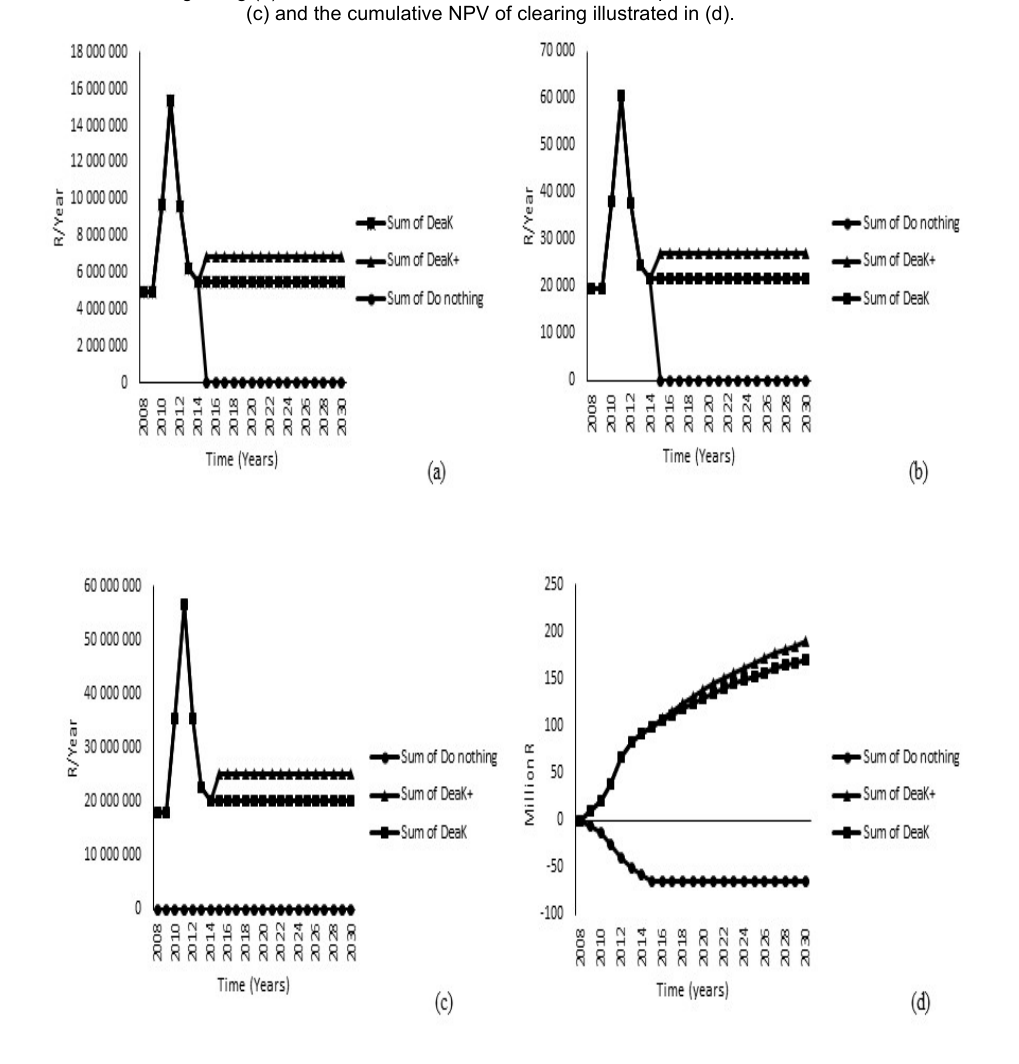
Value of water saved by clearing invasive (a) and the grazing benefit of clearing that opens the area to grazing (b). The net economic returns of value added products is illustrated in (c) and the cumulative NPV of clearing illustrated in